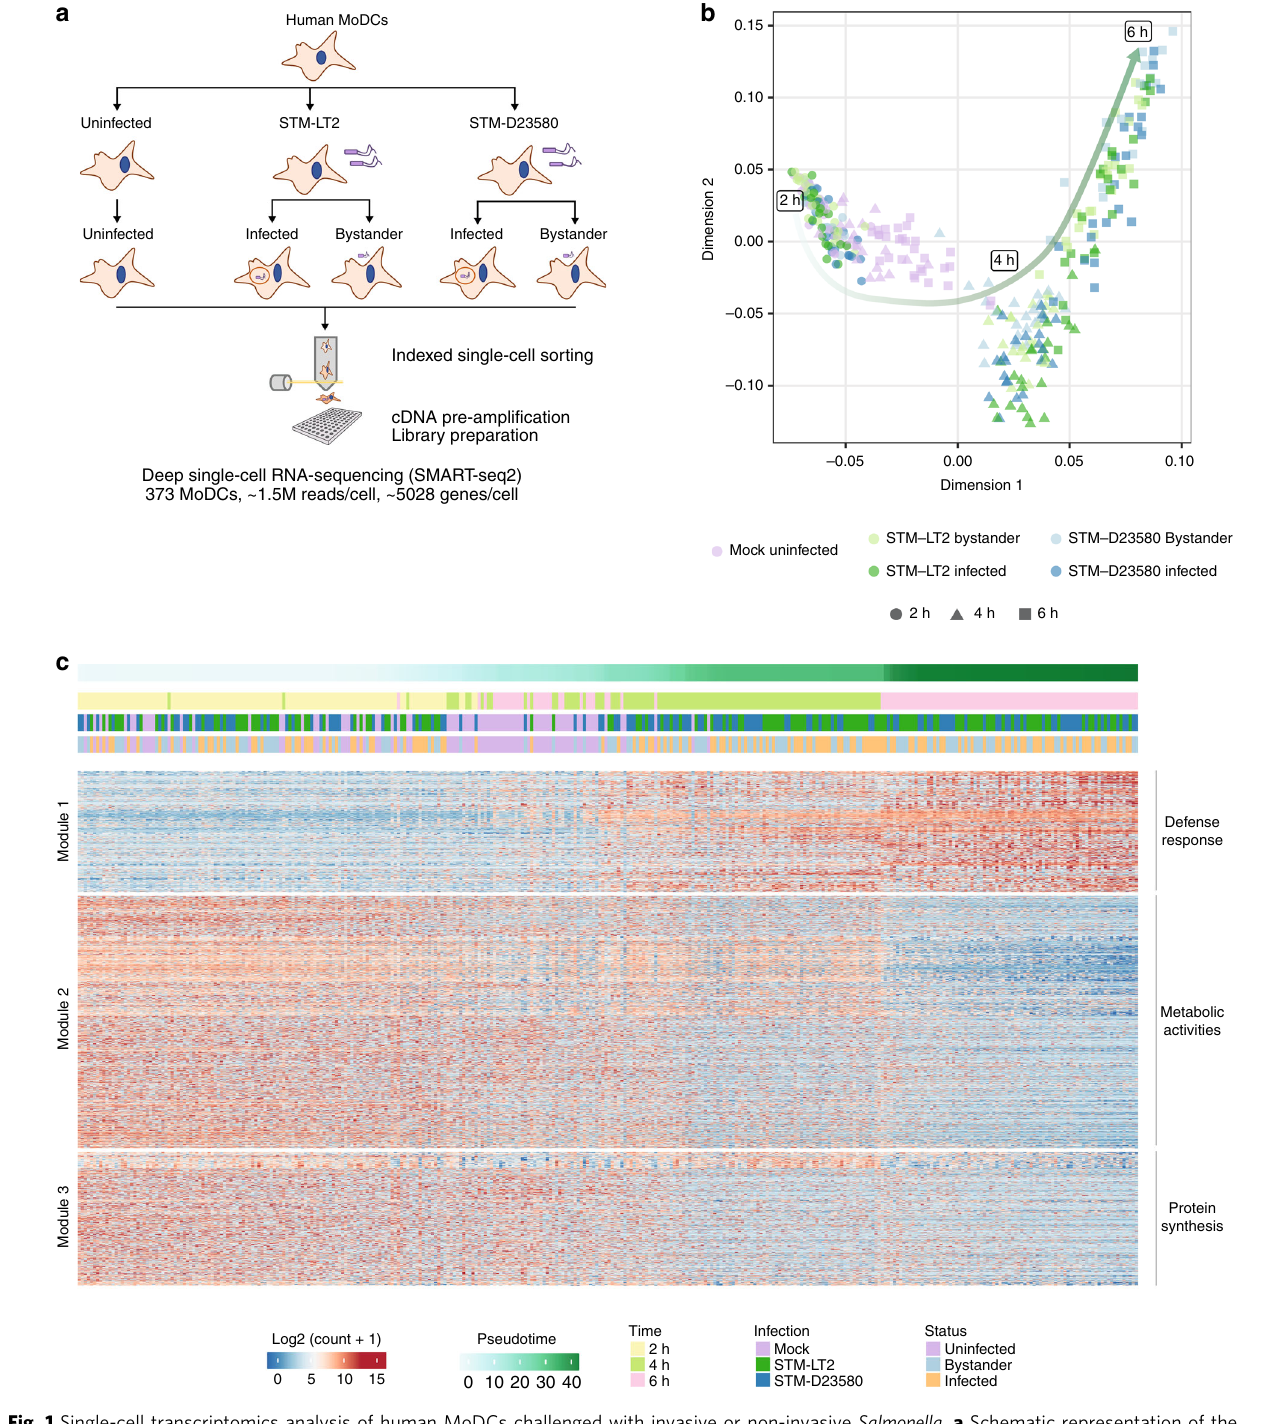
Fig. 1 Single-cell transcriptomics analysis of human MoDCs challenged with invasive or non-invasive Salmonella . a Schematic representation of the experimental design. Human MoDCs were challenged with labelled STM-LT2 or STM-D23580 bacterial strains. At 2, 4 and 6 h post infection (p.i.), infected and bystander cells were sorted and processed according to the Smart-seq2 protocol. b The diffusion map non-linear dimensionality reduction technique was applied on the fi rst 50 components of a principal component analysis (PCA) computed on the 500 most variable genes to visualize the high-dimensional relations between cells in the data set. The diffusion map reveals distinct cell populations that progress through the three time points of the experimental design. c Heat map displaying log 2 -transformed normalized counts for 3188 genes that signi fi cantly change with pseudotime across all single-cells ( q -value < 0.001). Pseudotime was computed from a set of 2759 genes differentially expressed between Salmonella -challenged cells at 2